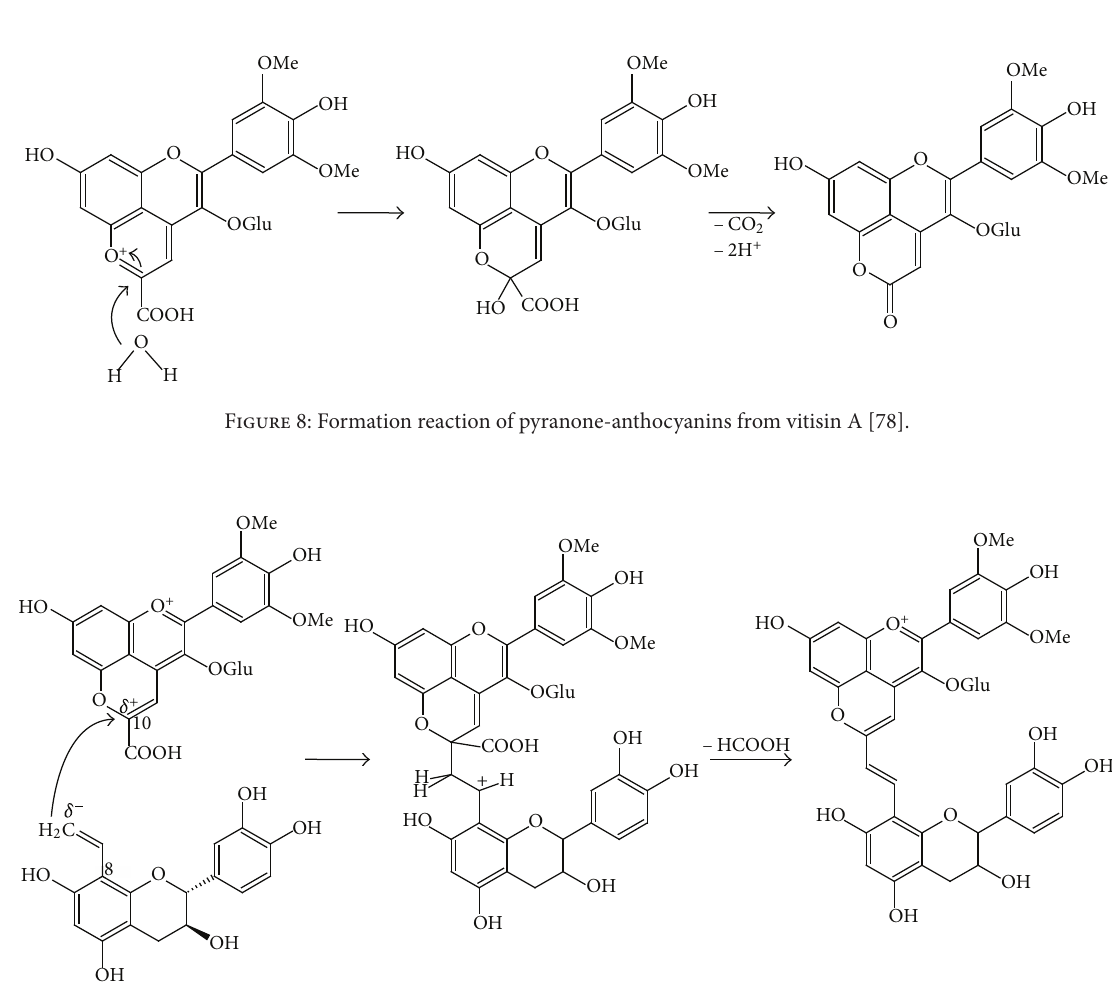
F 9: Proposed mechanism for the formation of Portisin A